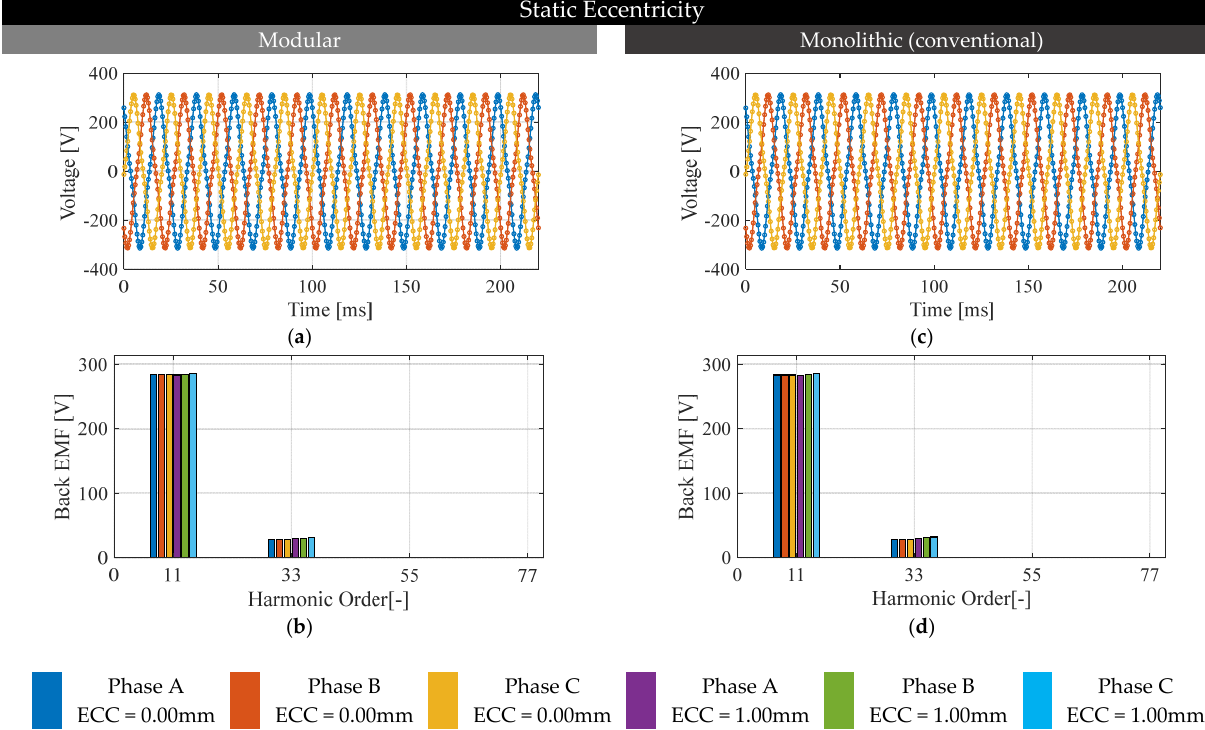
Figure 10. FE evaluation of the back ‐ emf in the presence of SE for a 24 ‐ slot, 22 ‐ pole PMSM and MPMSM: ( a ) back ‐ emf waveform for the modular machine, ( b ) back ‐ emf spectrum for the modular machine, ( c ) back ‐ emf waveform for the monolithic machine, ( d ) back ‐ emf spectrum for the monolithic machine.